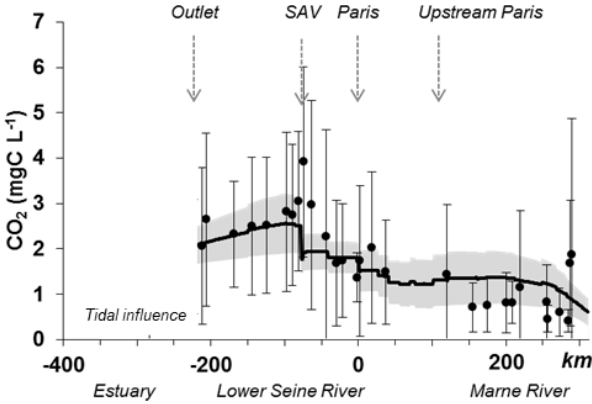
Figure 5. Observed (dots) and simulated (line) mean carbon dioxide concentrations (CO 2 , mgCL − 1 ) along the main stem of the Marne River (kilometer − 350 to 0) and the lower Seine River (kilome- ter 0–350) averaged over the 2010–2013 period. The simulation en- velope (gray area) represents standard deviations of simulated CO 2 concentrations. Whiskers are standard deviations between observed CO 2